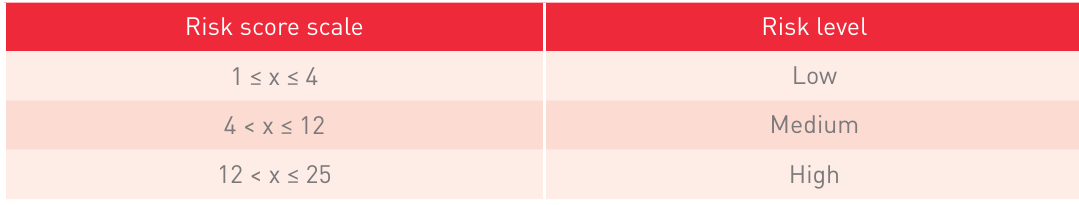
Table 3. Classification of Risk Level Risk score scale Risk level 1 x 4 Low ≤ ≤ 4 < x 12 Medium ≤ 12 < x 25 ≤